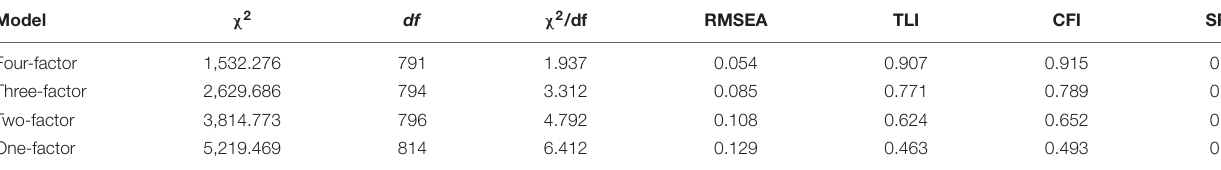
TABLE 2 | CFA and Chi-square difference test results.